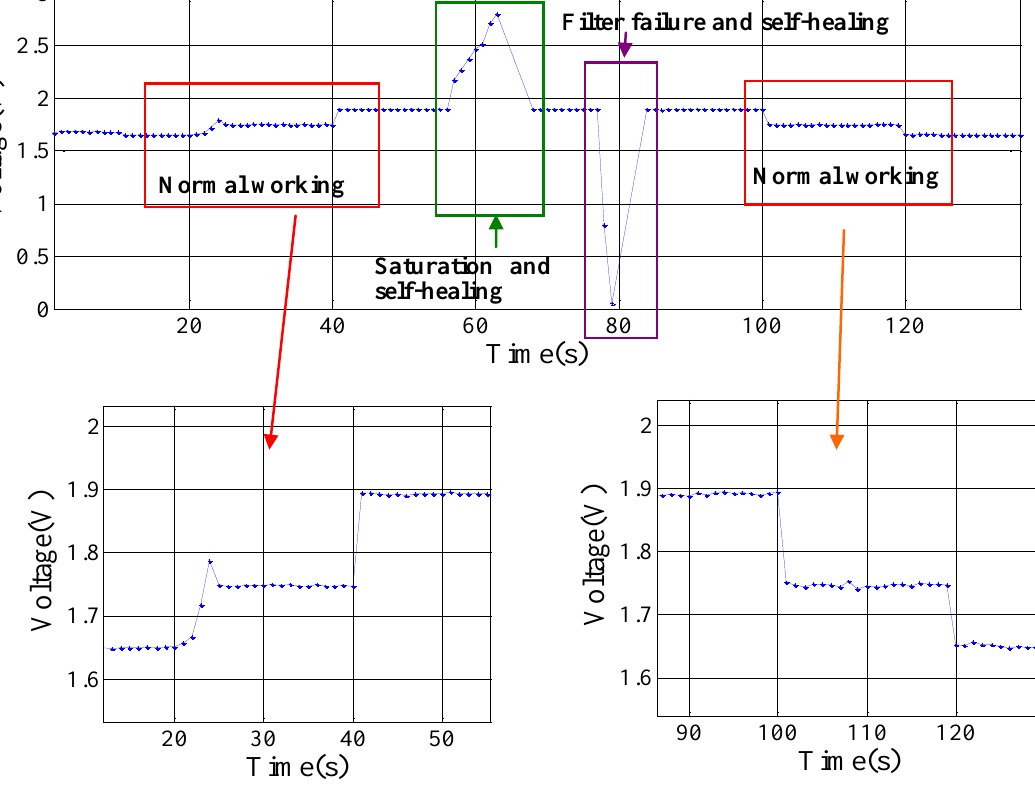
Figure 16. Output of the FPAA-based self-healing node during